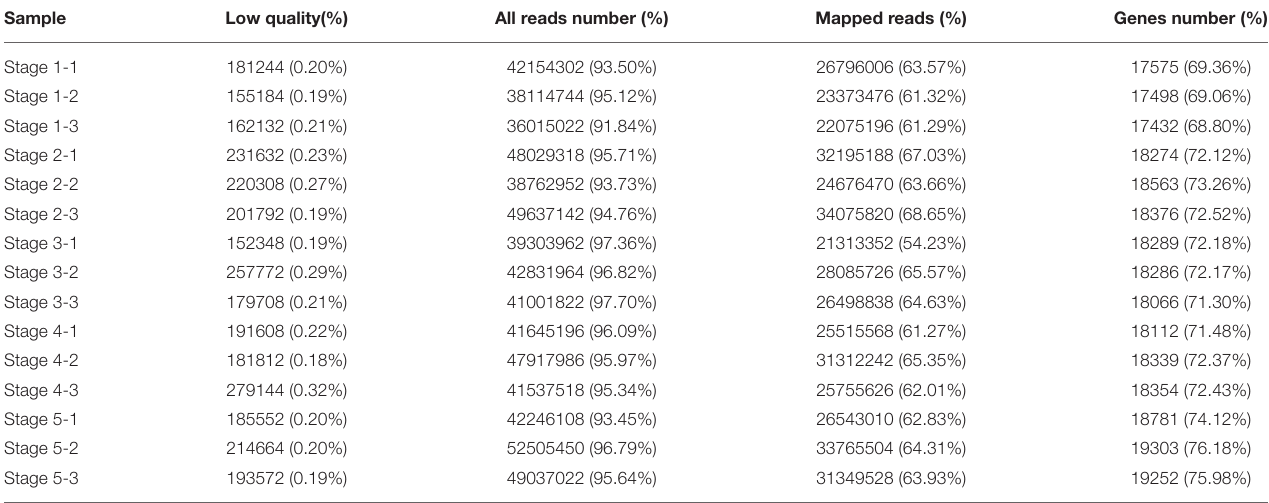
TABLE 2 | Statistics of ribonucleic acid sequencing (RNA-Seq) reads obtained from the 15 samples and mapping to the Madhuca pasquieri (Dubard) H. J. Lam reference transcriptome.